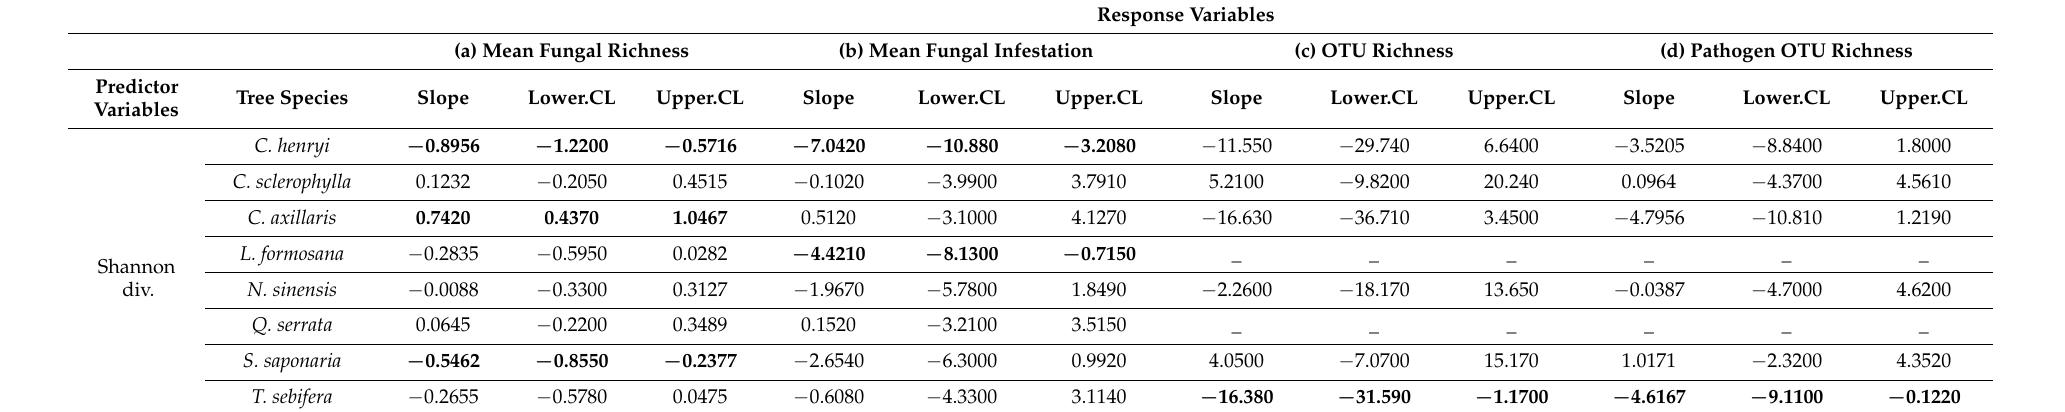
Table 2. Statistical analysis of Shannon diversity (Shannon div.) and proportion of the target tree at the local neighbourhood effects on (a) fungal richness, (b) fungal infestation, (c) OTU richness and (d) pathogen OTU richness per tree species. Linear mixed effects models with Shannon diversity or proportion of target tree in interaction and tree species as predictor variables and neighbourhood composition as a random factor. Significant values are those with confidence interval that do not overlap with zero, indicated by bold